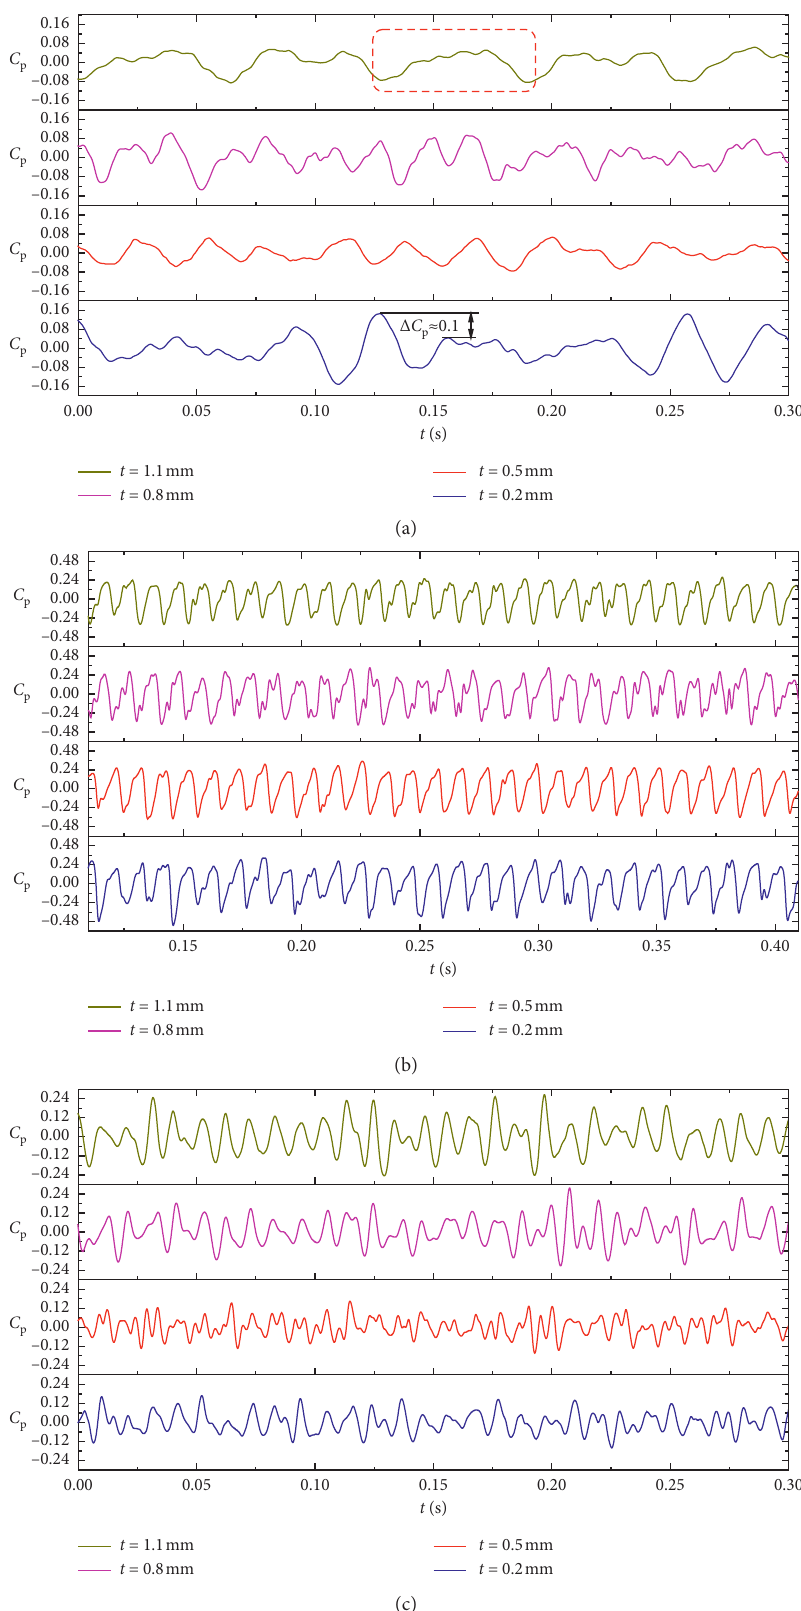
Figure 6: Time-domain characteristic of impeller inlet, middle, and outlet under different tip clearances. (a) Impeller inlet. (b) Impeller middle. (c) Impeller